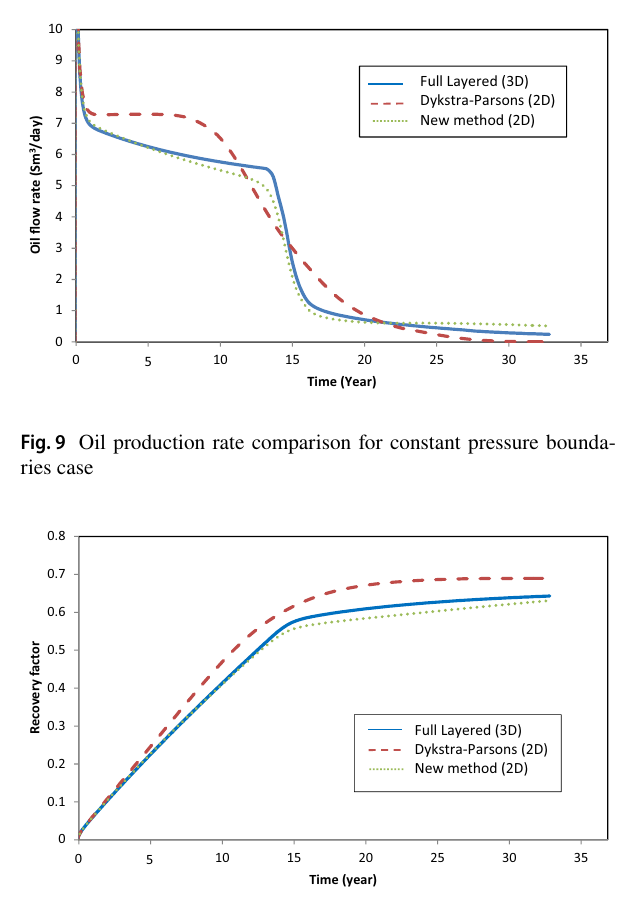
Fig. 10 Oil recovery comparison for constant pressure boundaries case